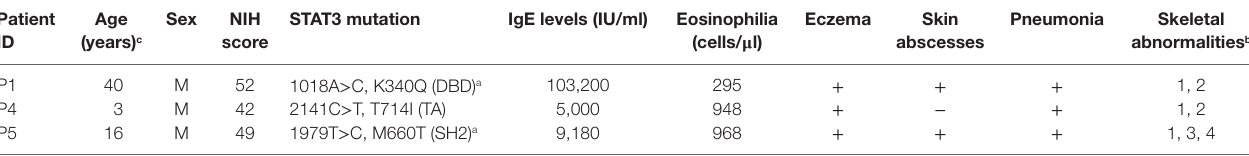
TaBle 1 | Clinical and genetic profile of hyper IgE syndrome